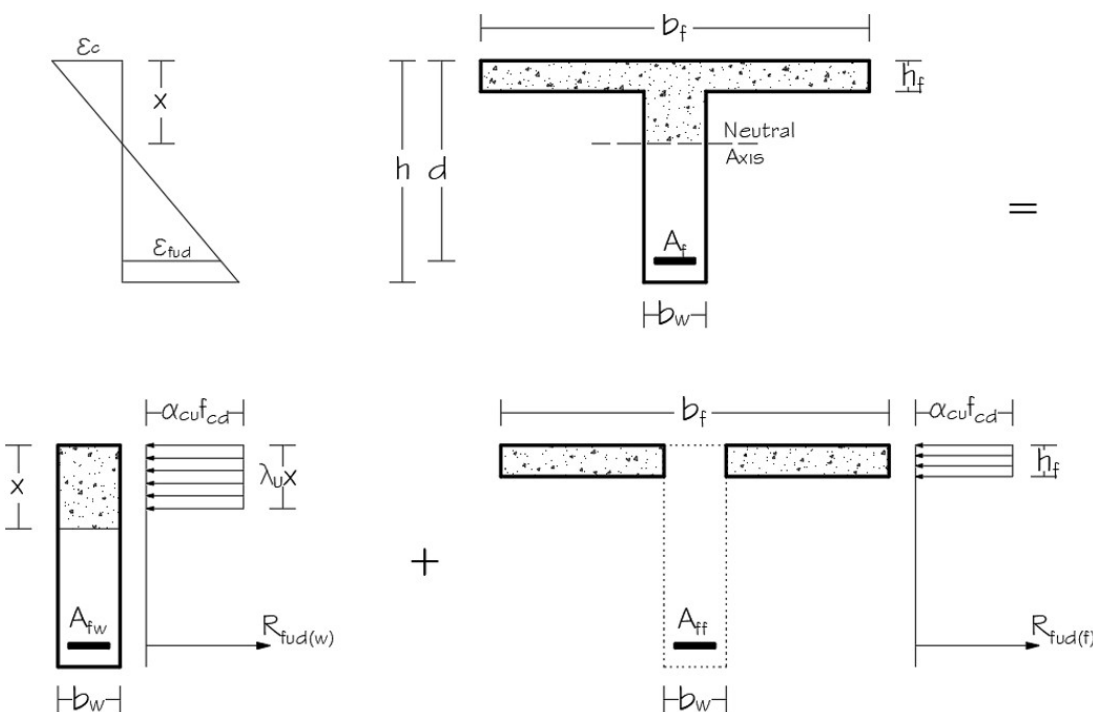
Figure 7. Compatibility and equilibrium of a tension-controlled section for which the concrete behaves non-linearly